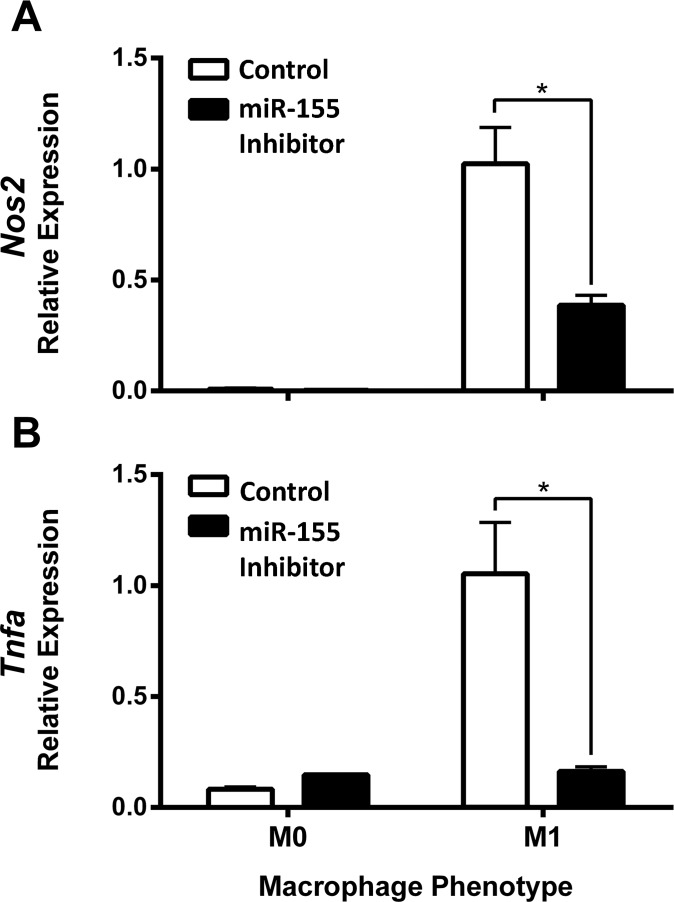
miR-155 inhibitor reduces M1 marker expression.(A) Inducible nitric oxide synthase (Nos2) and (B) Tumor Necrosis Factor (Tnfa) expression was determined by Real-Time PCR in wild-type bone marrow-derived macrophages in vitro activated in M0 or M1 conditions for 24 hours and transfected with a scrambled (n = 3) or a miR-155 oligonucleotide inhibitor (n = 3–4). Gene expression is expressed as a percentage +/- SEM of the scrambled M1 condition. Unpaired t-test, *p<0.05. Data reproduced in two independent experiments.